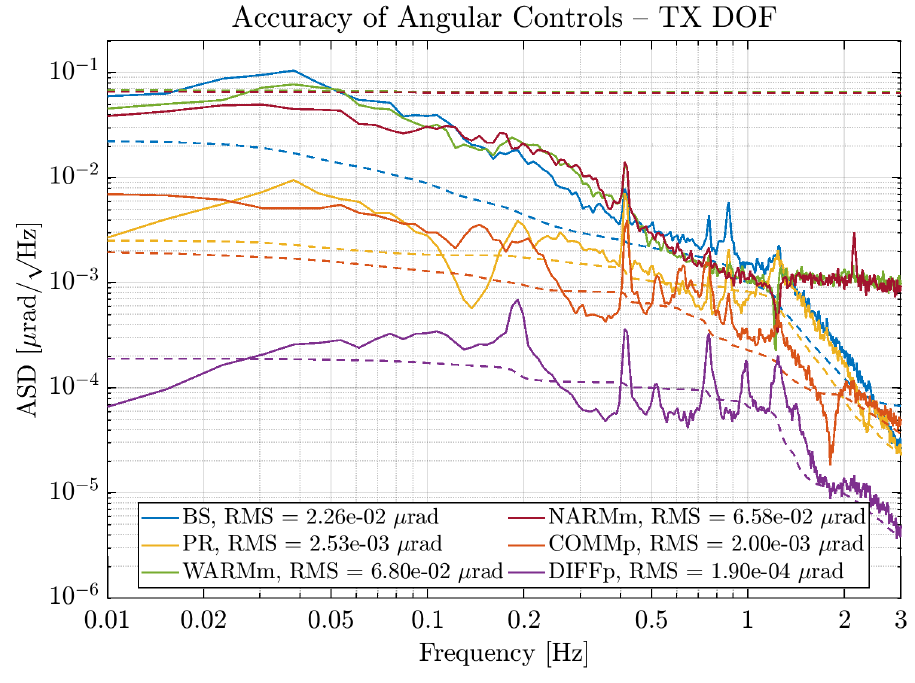
Figure 8. Amplitude Spectral Density (ASD) of the accuracy of Angular Controls in Phase III, θ x DOFs. ( − ) modes are defined in the single cavity basis (see text). Dashed lines are the RMS of the signal of the same colour.